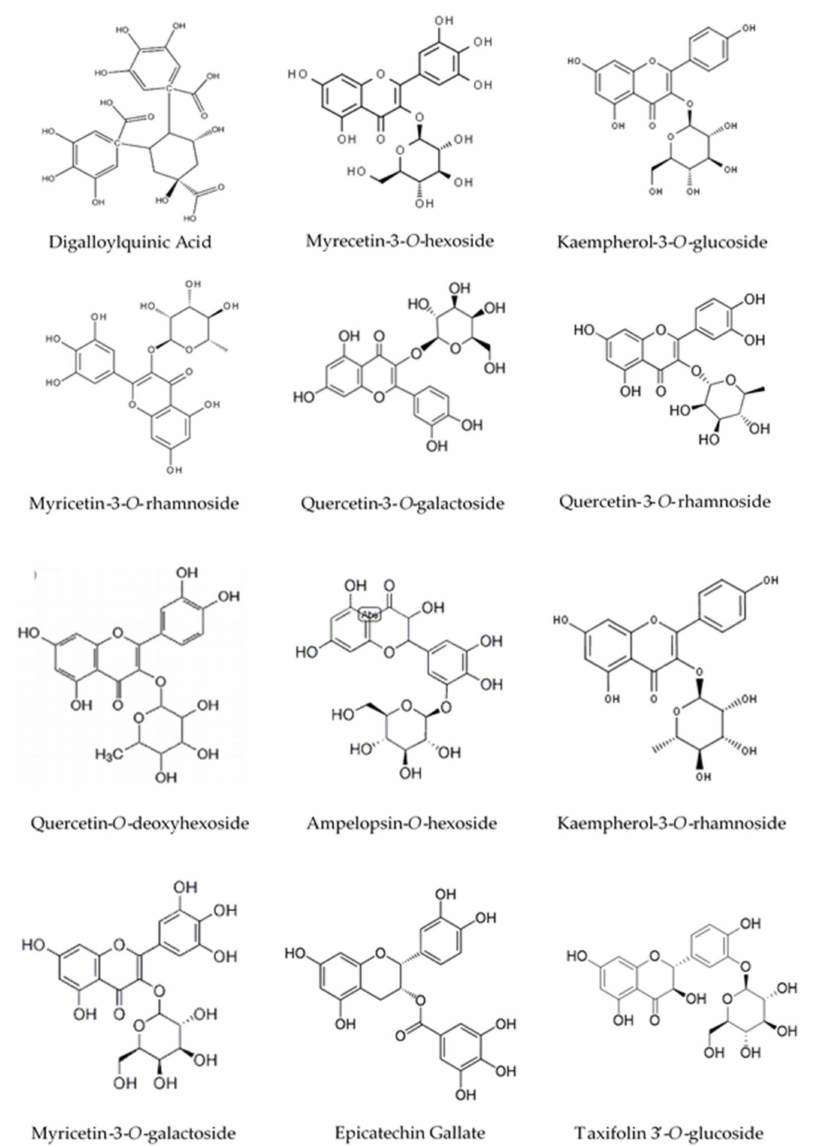
Figure 2. Structure of the constituents identified in the ethyl acetate extract (EAE) by